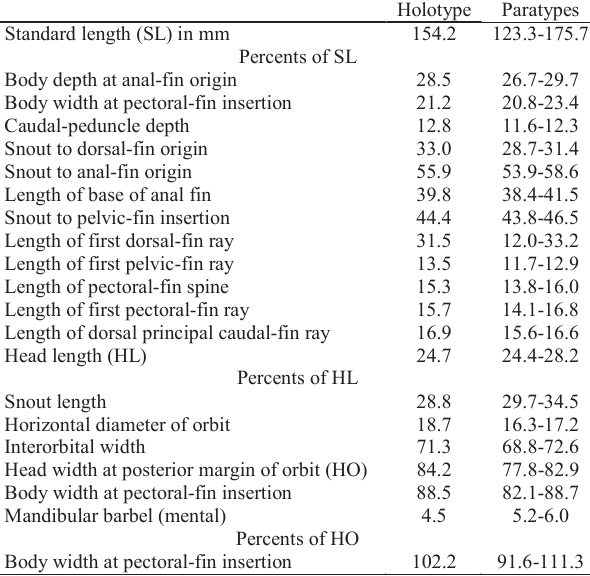
Table 1. Morphometric data of the holotype and paratypes (4 exs) of Tetranematichthys barthemi